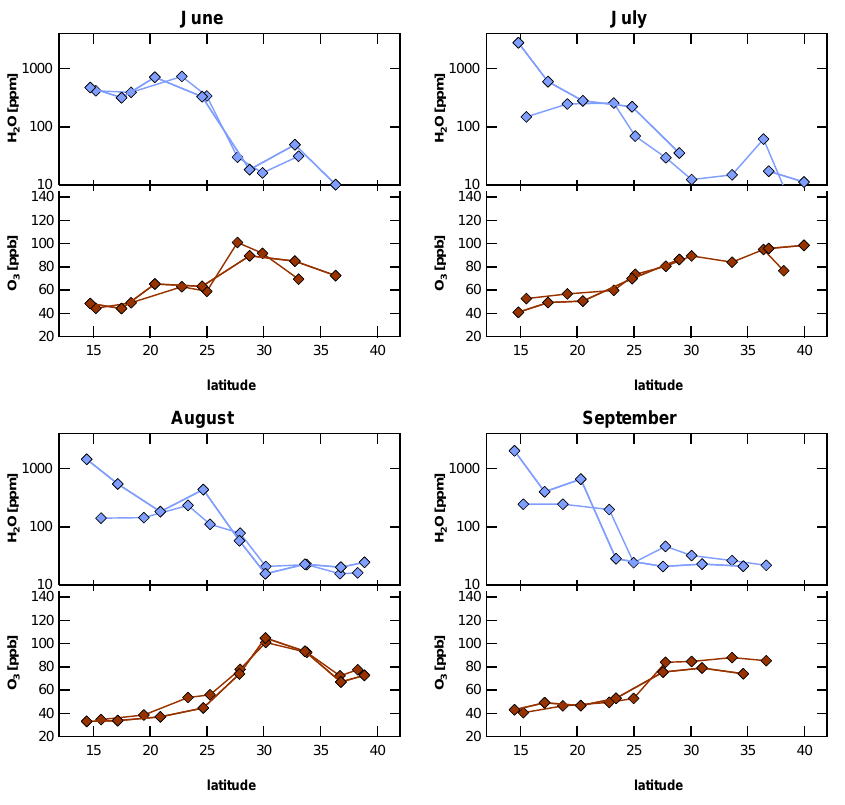
Fig. 6. Latitudinal distributions of H 2 O and O 3 mixing ratios integrated over the sampling periods of whole air samples for flights between Frankfurt and Chennai in June, July, August and September